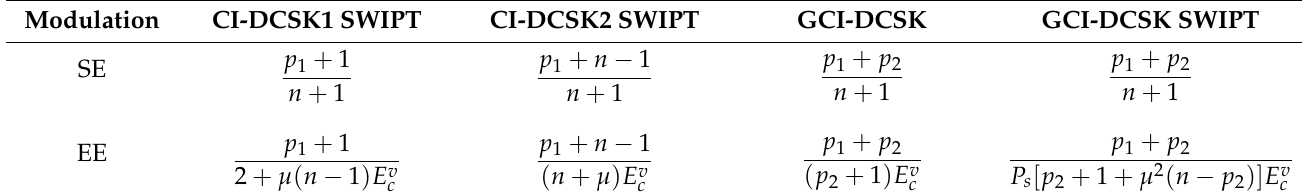
Table 1. The formulas of EE and SE for the four